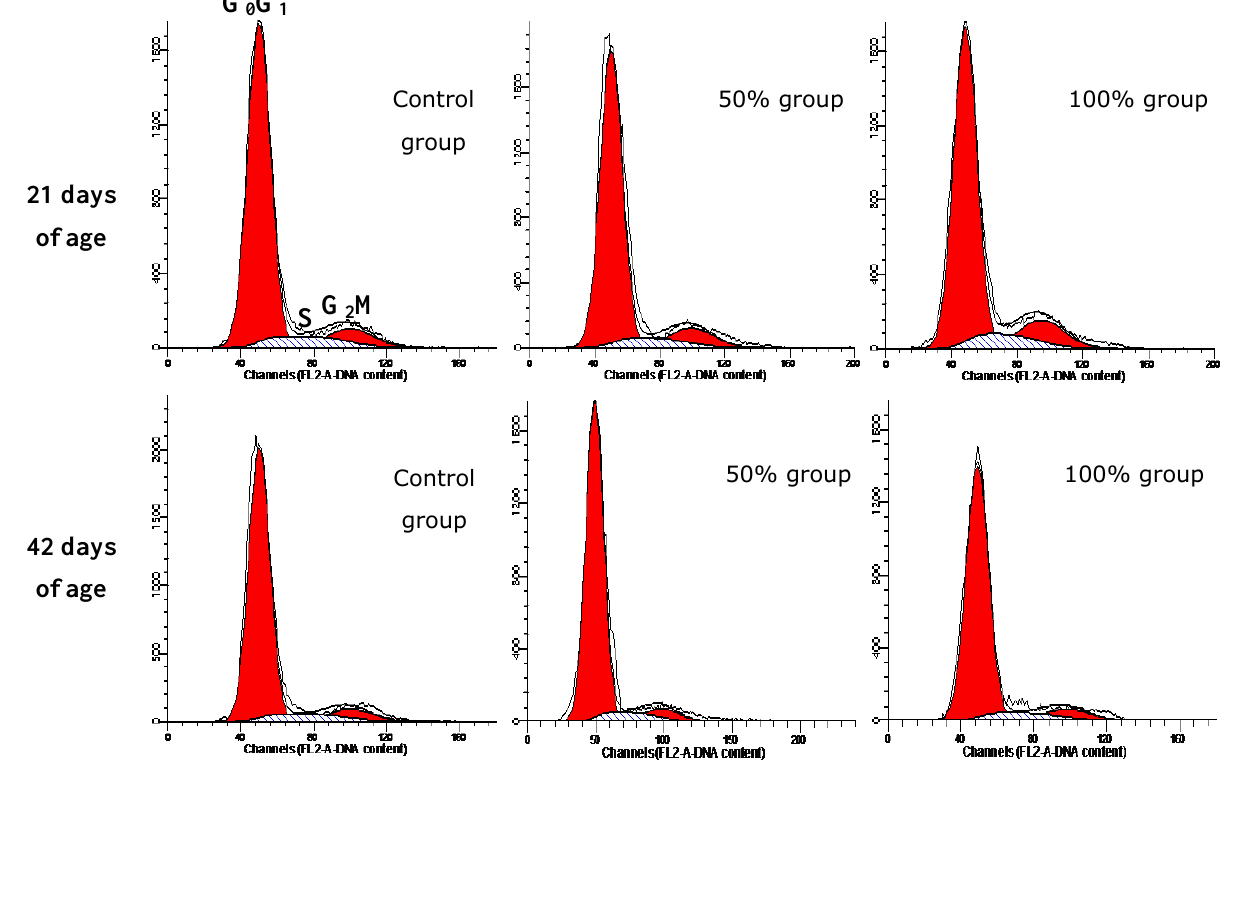
Figure 4. DNA histograms of splenocytes’ cell cycles. The percentage of G higher in 50% and 100% group than in control group at 21 days of age. The percentage of S phase is lower in 50% and 100% group than in control group at 42 days of